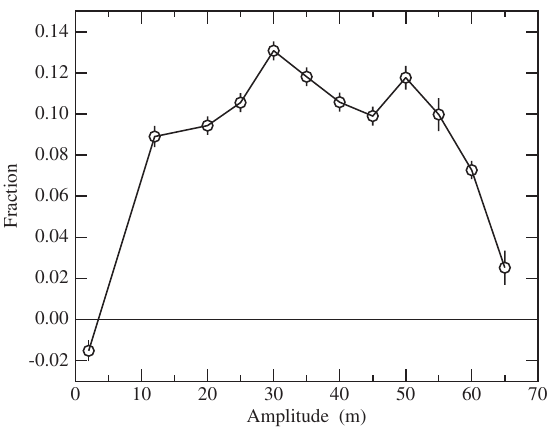
FIG. 14. Distribution of values of A leading to the model calculation of Fig. 12. Note that the first coefficient is negative, an unphysical result.